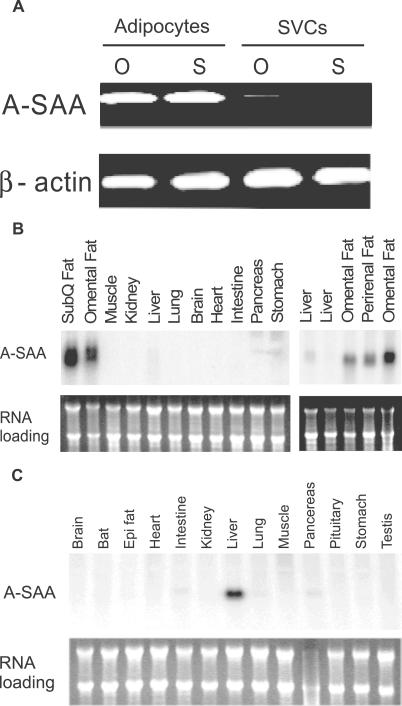
Tissue-Restricted Expression of A-SAA mRNA(A) Representative semiquantitative RT-PCR analysis of A-SAA and β-actin mRNA in SVCs and adipocytes fractionated from human omental (O) and subcutaneous (S) adipose tissues.(B and C) Northern analyses of multiple tissue blots from the human and mouse, respectively. For all Northern analyses, 15 μg of total RNA from the indicated tissues were electrophoresed, blotted onto a nylon membrane, and hybridized with a radiolabeled human (B) or murine (C) SAA2 cDNA probe, which detects both SAA1 and SAA2 (upper gels). Equality of RNA loadings was estimated by ethidium bromide staining (lower gels). Comparison of A-SAA expression was made in five independent participants (B, right). Epi, epididymal; SubQ, subcutaneous